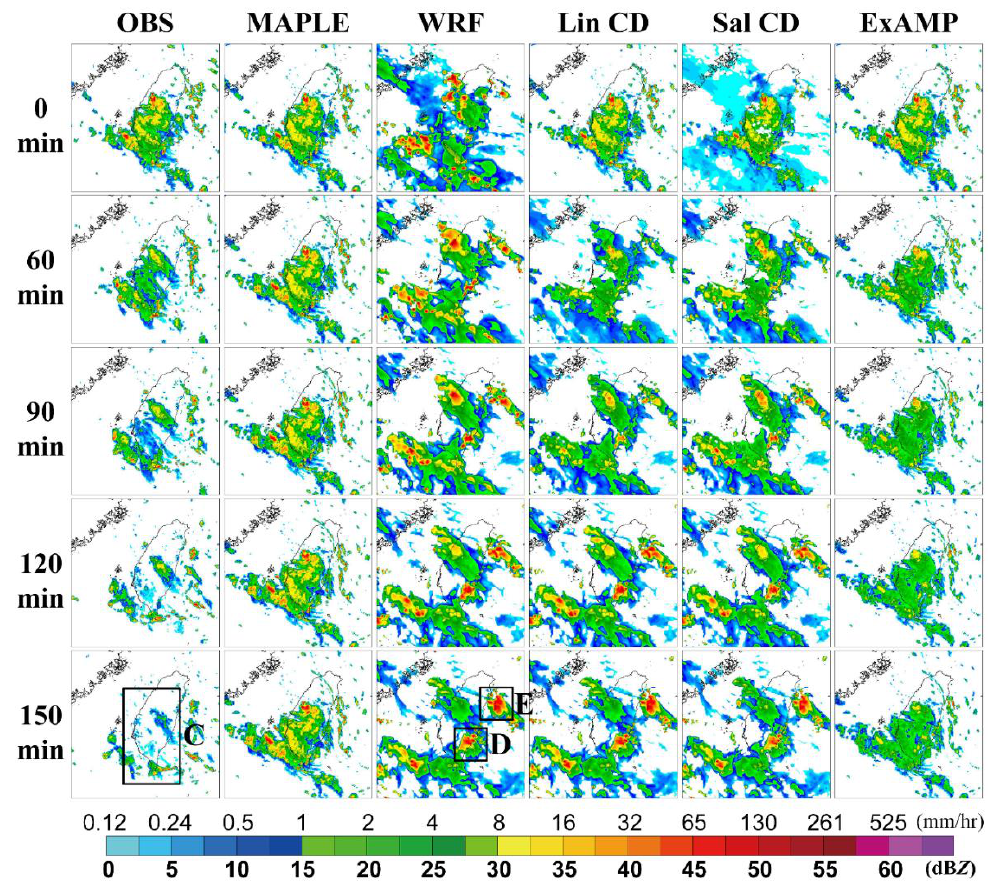
Figure 4. As in Figure 3, but for an LT event at 10:30 UTC 2 August. Rectangles C, D and E highlight the discussed areas.